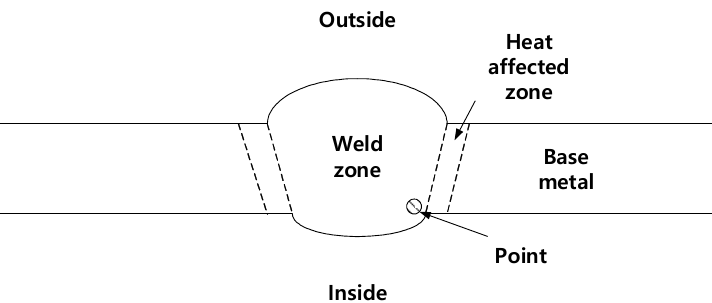
Figure 6. Schematic illustration of welded pipes for instrumented indentation technique.